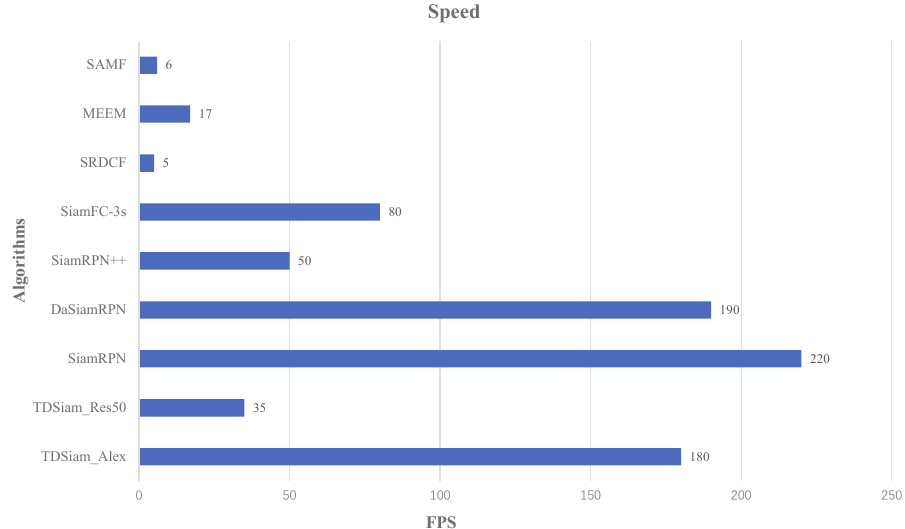
Figure 16. Speed performance of the proposed method and other state-of-art trackers on the UAV123